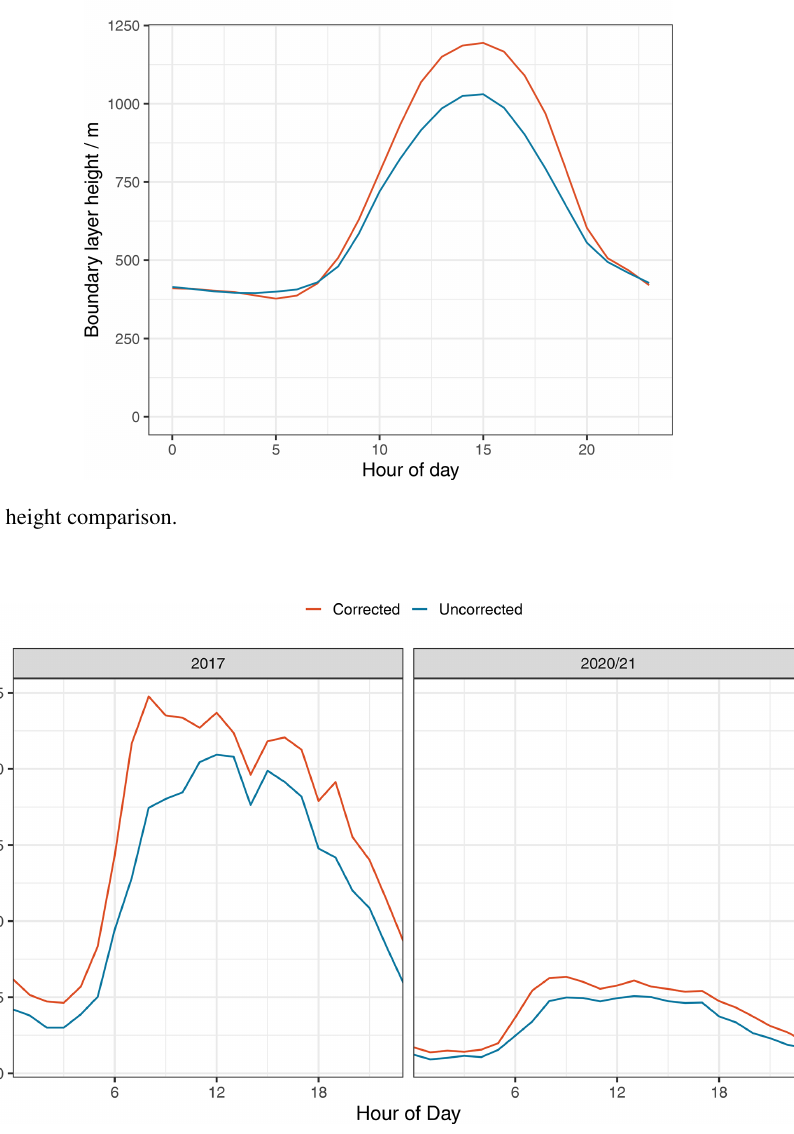
Figure A6. Diurnal profiles comparing uncorrected and vertical-flux-divergence-corrected NO x flux for the 2017 and 2020–2021 measure- ment